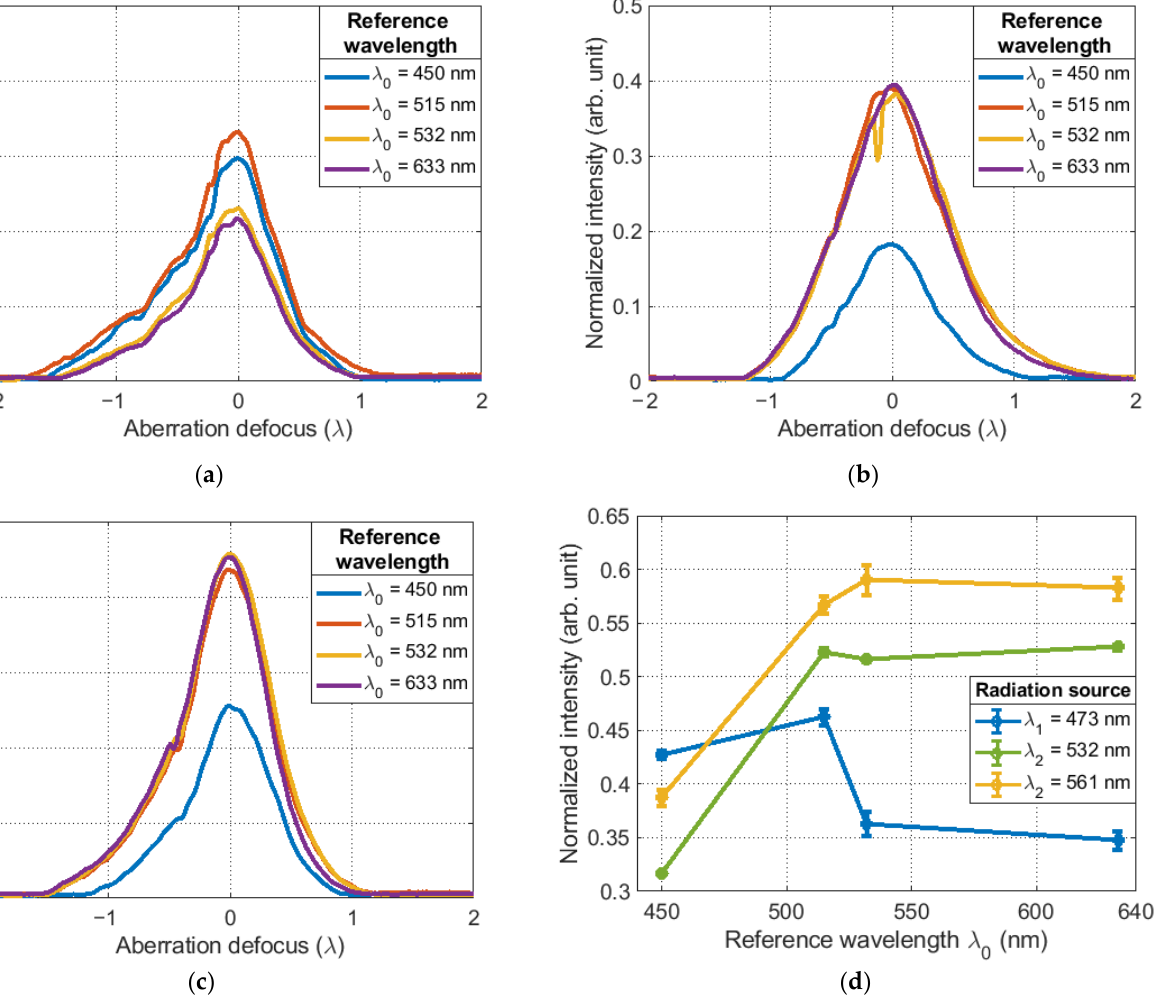
Figure 6. ( a ) Сross section of the correlation function from the Figure 5a,b; ( b ) normalized depend- ences of the amplitude of the maximum correlation response.